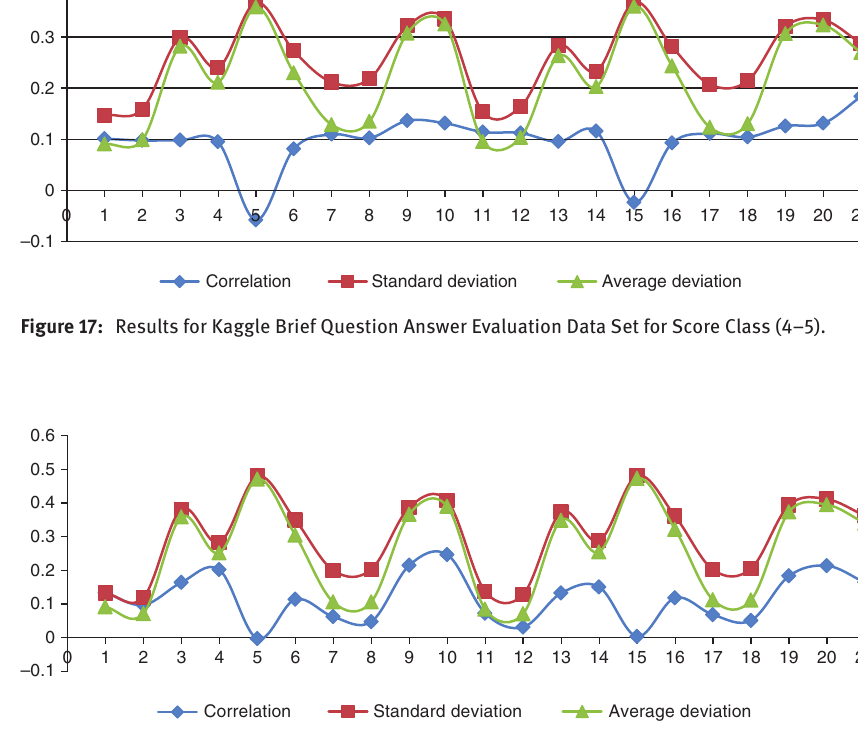
Figure 18: Overall Results for Kaggle Brief Question Answer Evaluation Data